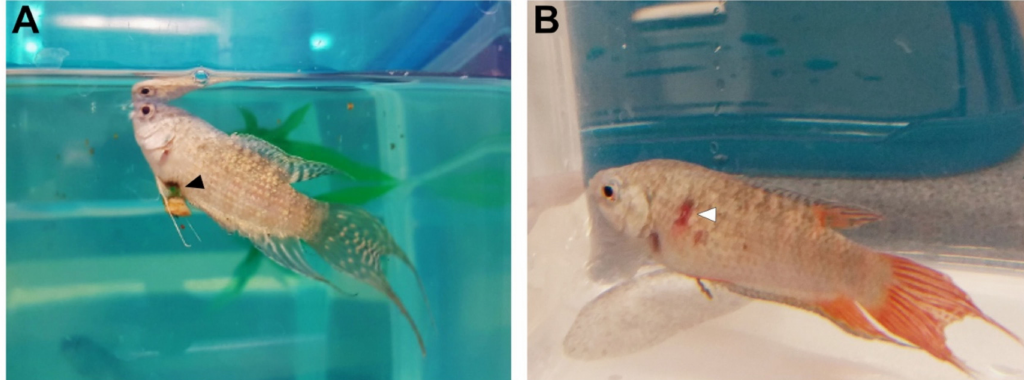
Figure 4. Disease symptoms of captive paradise fish. ( A ) Sick paradise fish male. Note the loss of color and the necrotized tissue (black arrowhead) in the region of the anal papilla. ( B ) Female with inflamed scratches on the body surface (white arrowhead). Photo credit: Tam á s Annus and Anita R á cz.